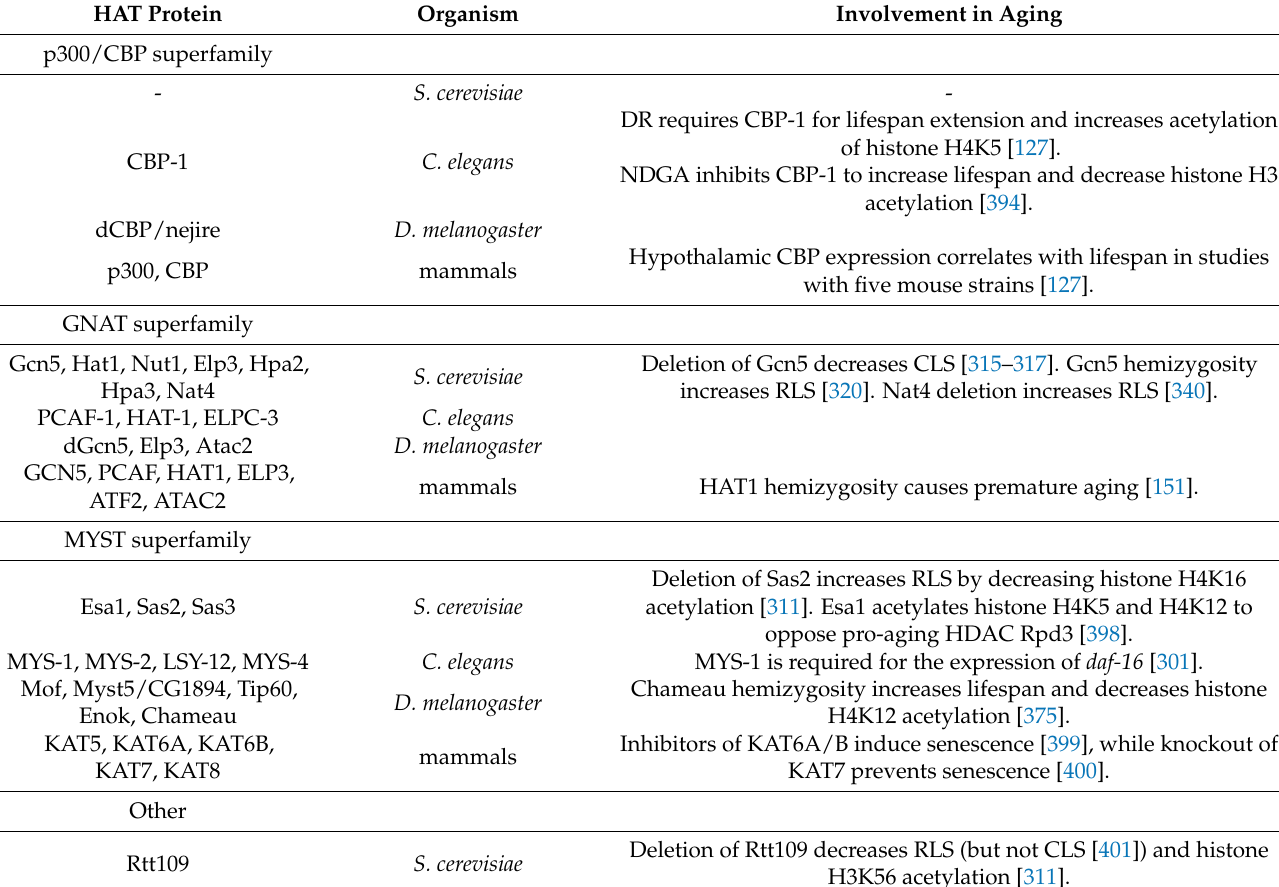
Table 1. HATs and their involvement in aging in model